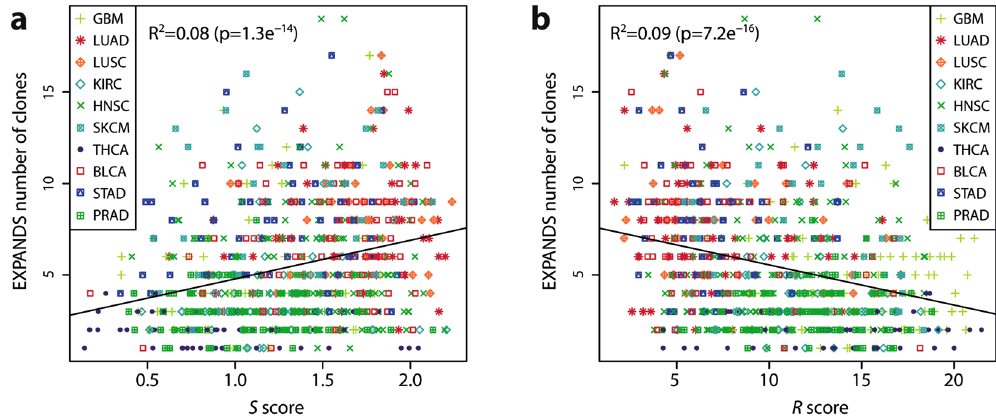
Figure 6. Comparison with other methods and datasets. ( a , b ) Correlation between S score ( a ), R score ( b ) and the number of clones predicted by the EXPANDS software. Different point styles and colours correspond to different cancer